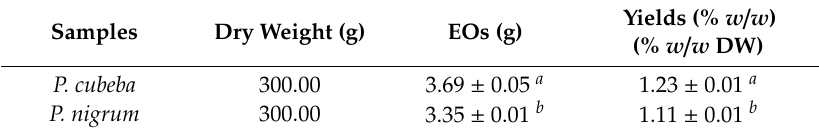
Table 3. Yields of essential oils extracted from P. cubeba and P. nigrum.